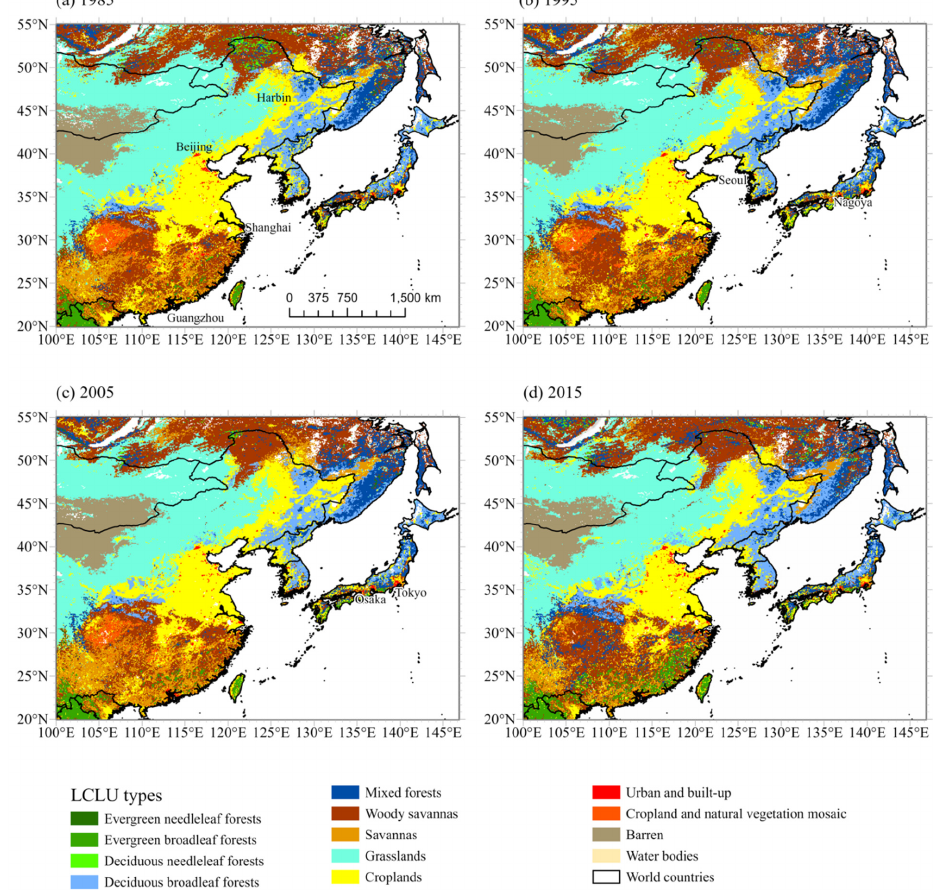
Figure 5. LCLU maps in the EASM region in ( a ) 1985; ( b ) 1995; ( c ) 2005; and ( d ) 2015. According to the trend analysis, forests and croplands significantly increased in the EASM region from 1982 to 2015 at annual rates of 5260 ± 2614 km 2 and 3952 ± 1334 km 2 , respectively. In contrast, grasslands significantly decreased by 7594 ± 1732 km 2 /year (Fig- ure 6). The urban and built-up, cropland/natural vegetation mosaic, and water bodies de- creased at rates of 495 ± 239, 1536 ± 437, and 125 ± 23 km 2 /year, respectively (Figure A3). Even though barren lands increased by approximately 394 ± 634 km 2 /year, this trend was statistically insignificant (Figure A3). The increasing forests and croplands in the EASM region are consistent with findings based on country-level forest and CCI LC croplands data by [54]. Meanwhile, the LUH data revealed a decreasing trend for grasslands [66]. The decreasing trend in urban lands is mainly caused by classification errors linked to the coarse resolution, and this requires improvement in the future.